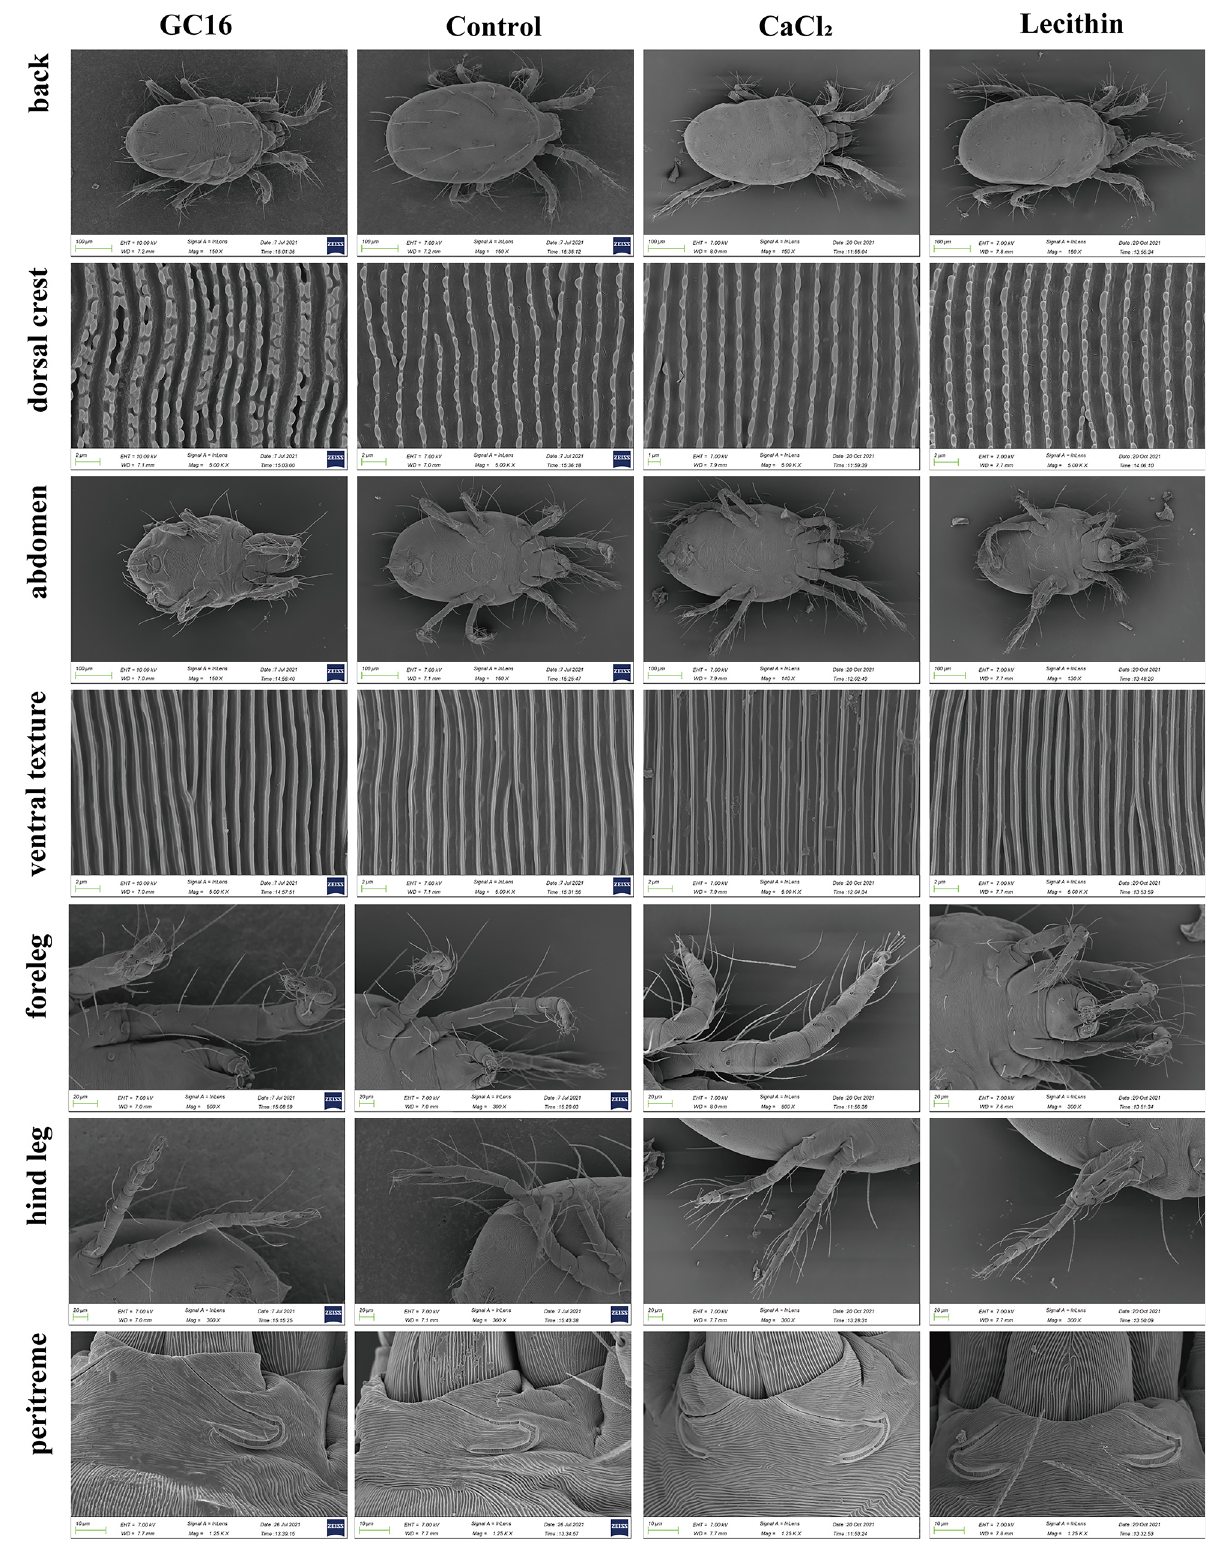
Figure 5. Scanning electron microscopy (SEM) observation of T. pueraricola after treated for 24 h. The treatments include GC16, Control (water), CaCl 2 , and lecithin. The parts that were photographed included the back, dorsal crest, abdomen, ventral texture, foreleg, hind leg, and